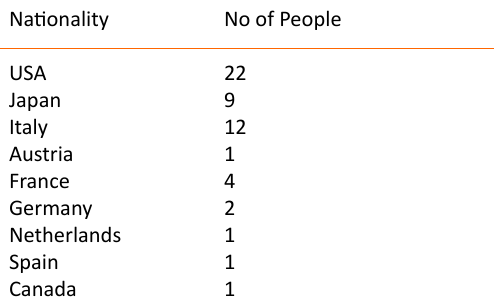
Table 2. Account of patients and their nationality